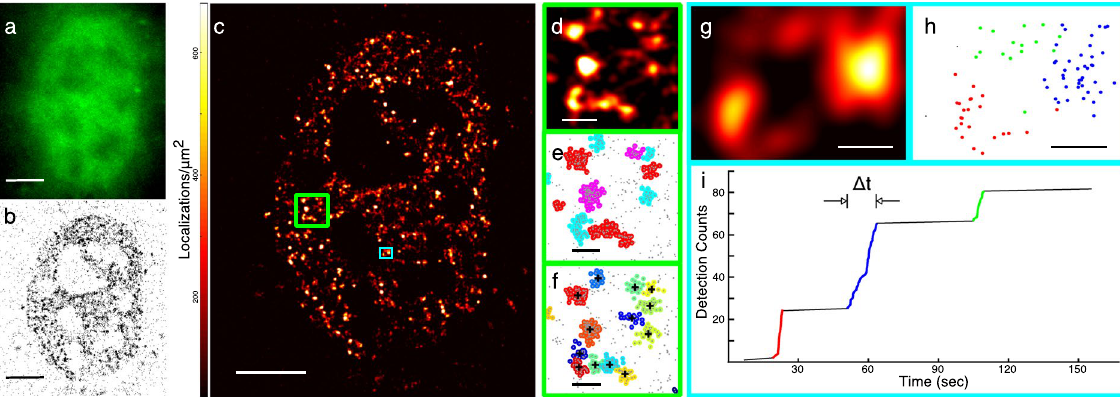
Figure 1. qSR facilitates analysis of the spatial organization and temporal dynamics of proteins in live cell super-resolution data. ( a – c ) Conventional fluorescence image, pointillist image, and super-resolution reconstruction image of RNA Polymerase II inside a living cell. ( d,e ) Spatial clustering of the data within the region highlighted in the large green box shown in ( c ) is performed using the DBSCAN algorithm embedded in qSR. ( f ) Spatial clustering of the same region is performed using the FastJet algorithm embedded in qSR. ( g – i ) Time-correlation super-resolution analysis (tcPALM) reveals temporal dynamics within a region of interest (ROI) shown in ( g ), and highlighted in the small cyan box in ( c ). In ( i ), for the selected ROI, a plot of the cumulative number of localizations as a function of time is represented. Localizations belonging to the three temporal clusters highlighted in ( i ) are plotted spatially in their corresponding (red, blue, green) colors in ( h ). Clusters of localizations which are grouped by time in (i) are also distinctly clustered in space. Scale Bars: ( a – c ) 5 µ m; ( d – f ) 500 nm ( g,h ) 200